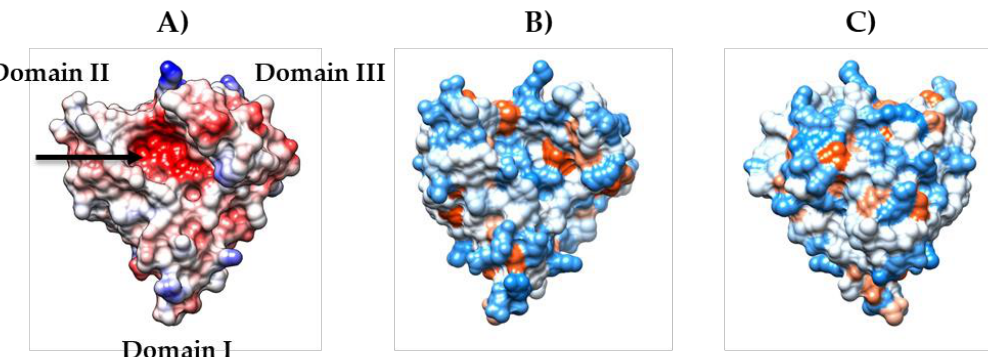
Figure 1. ( A ) Mapping of the electrostatic potentials on the molecular surface of the grape VVTL1 4L5H. The negative and positive potentials are colored in red and blue, respectively, while neutral areas are in white. The arrow indicates the acidic cleft located between domains I and II. (B, C) Mapping of the surface hydrophobicity of the VVTL1 4L5H: ( B ) front view; and, ( C ) back view (rotated approximately 180˚). Hydrophobicity continuum starts from dodger blue for the most hydrophilic areas, to white, to orange and to red for the most hydrophobic areas. The images were generated using the Chimera 1.14 software [27].